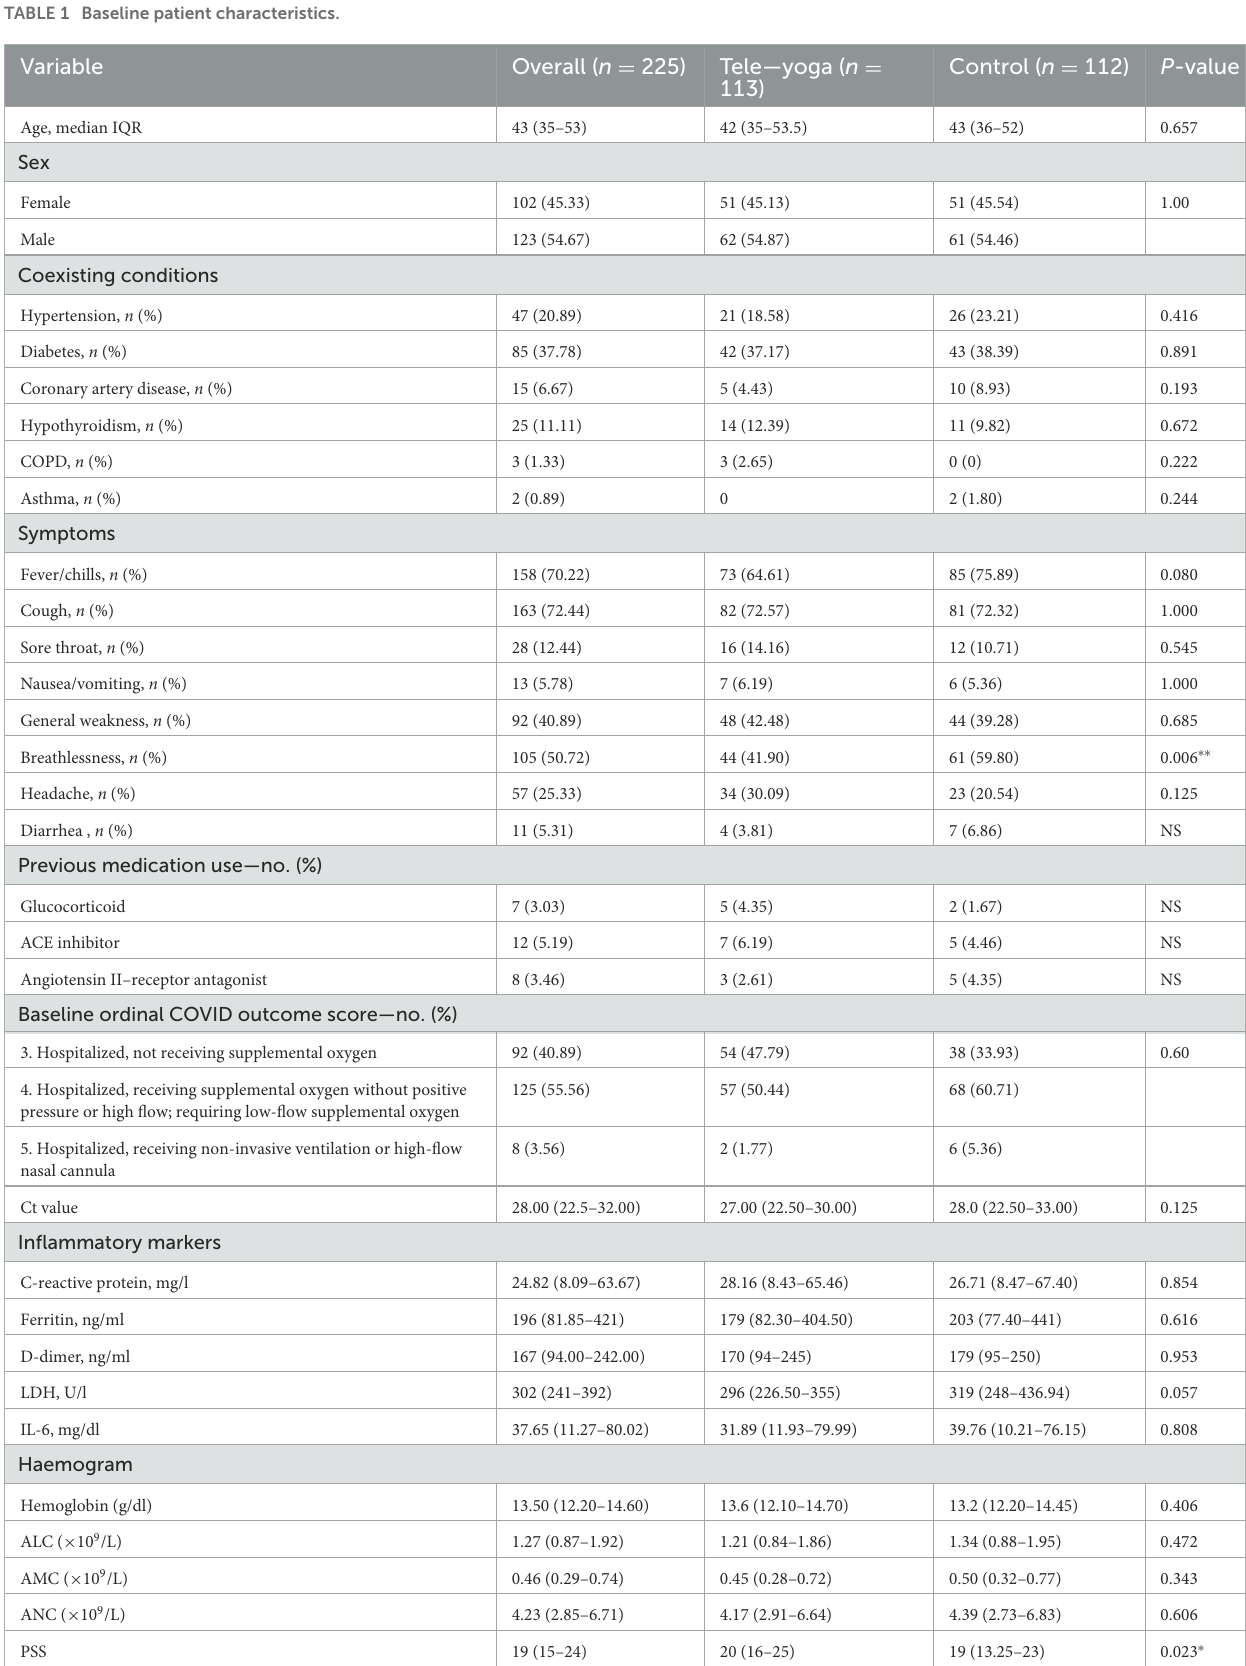
TABLE 1 Baseline patient